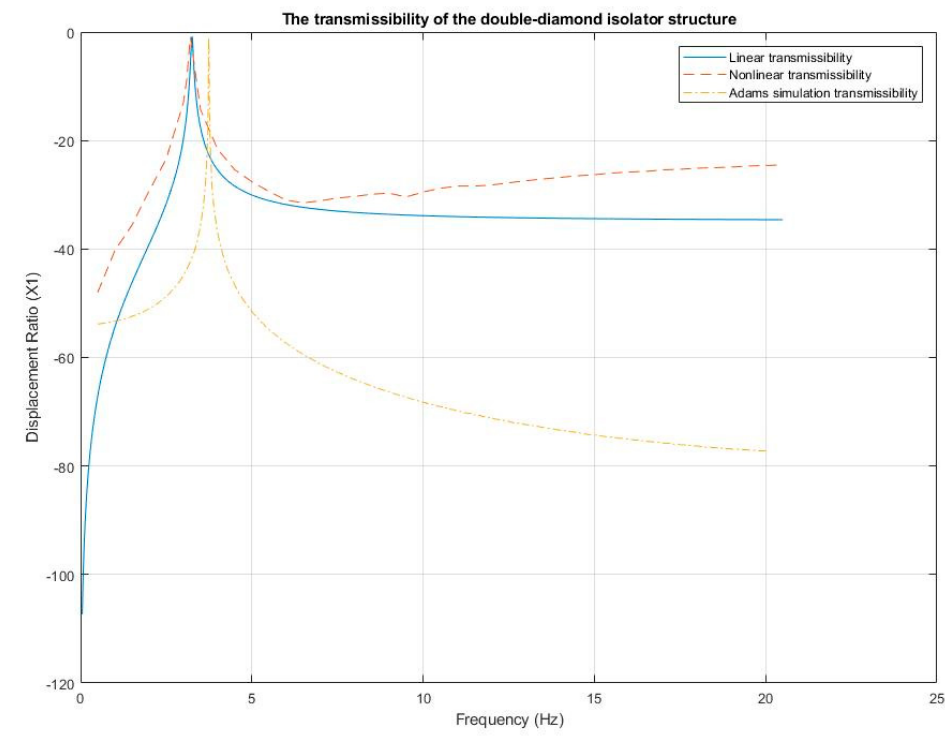
Figure 16. The transmissibility of the double-diamond isolator structure supporting a mass model using Adams simulation model and Matlab code.